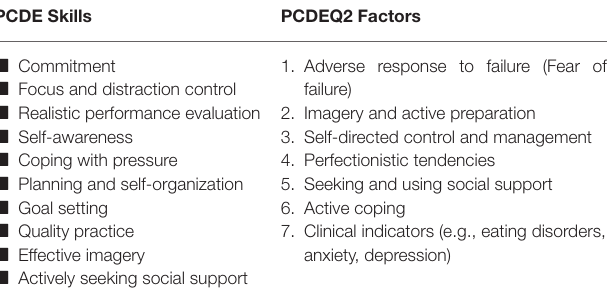
TABLE 1 | PCDEs and factors from the PCDEQ2. PCDE